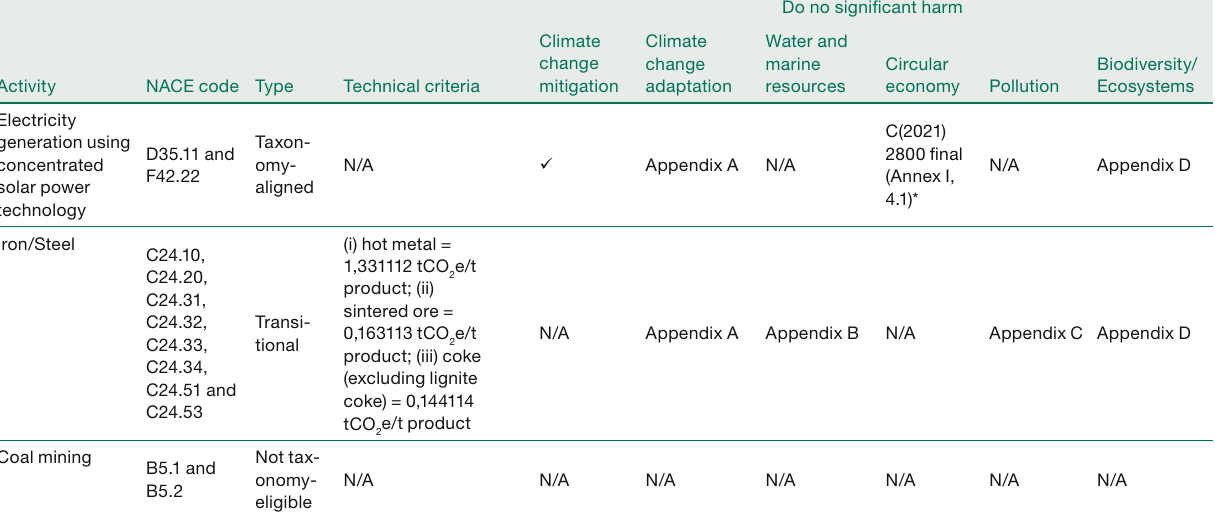
Examples of taxonomy classifi